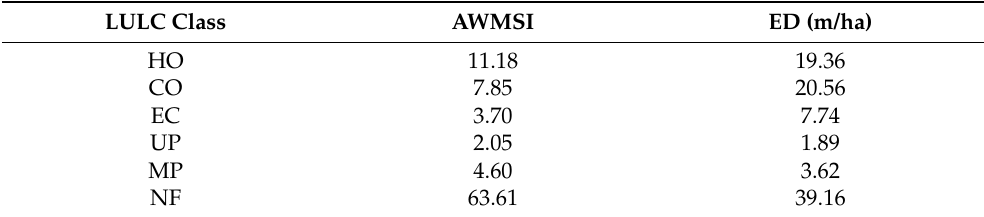
Table 6. Weighted mean shape index (AWMSI) and edge density (ED).